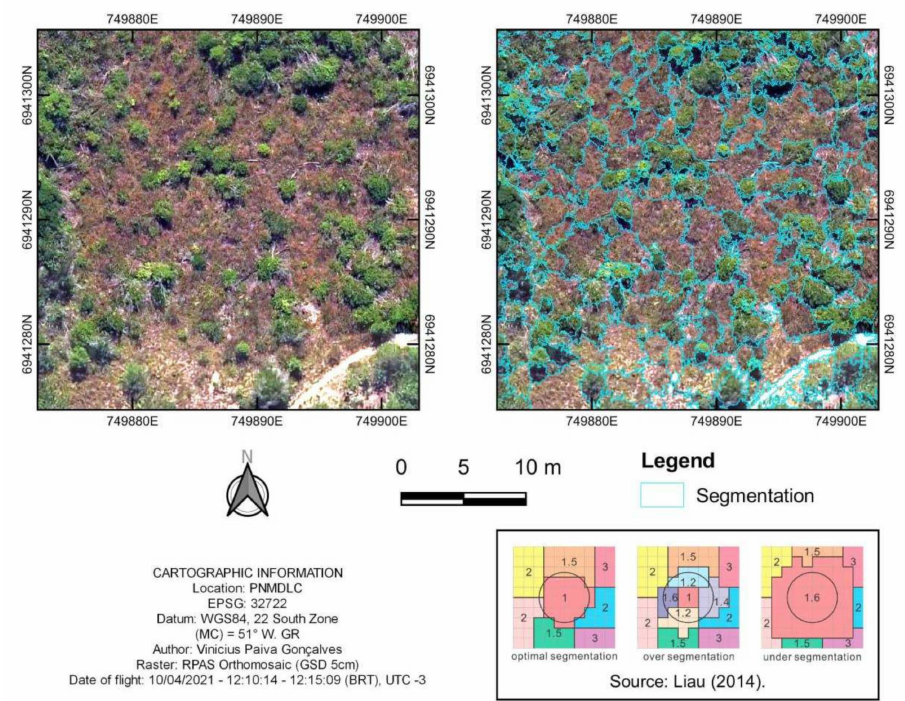
Figure 3. Segmentation example in the PNMDLC area in comparison to visual reference proposed by Liau [46]. CRS: EPSG 32722. Horizontal datum WGS84, UTM projection system, 22 South Zone. MC 51 ◦ W. GR. Raster: RPAS orthomosaic (GSD 5 cm). Flight date: 10/04/2021, 12:10:14–12:15:09 Brasilia Time (BRT),